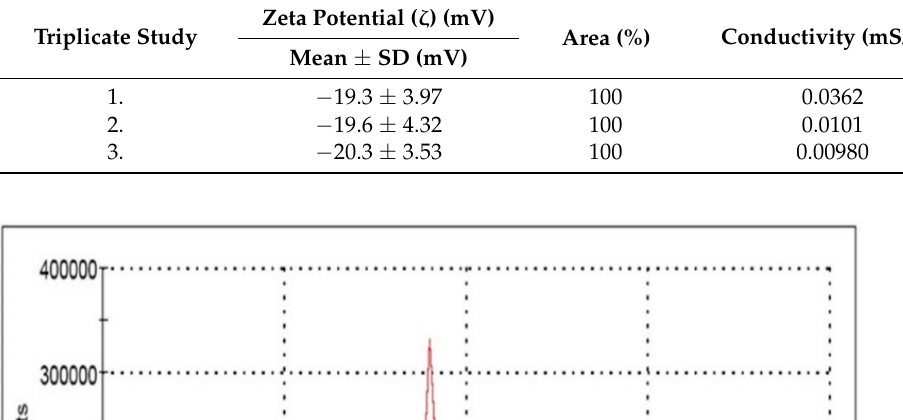
Table 1. Zeta potential value of AgNPs synthesized by E . hormaechei .